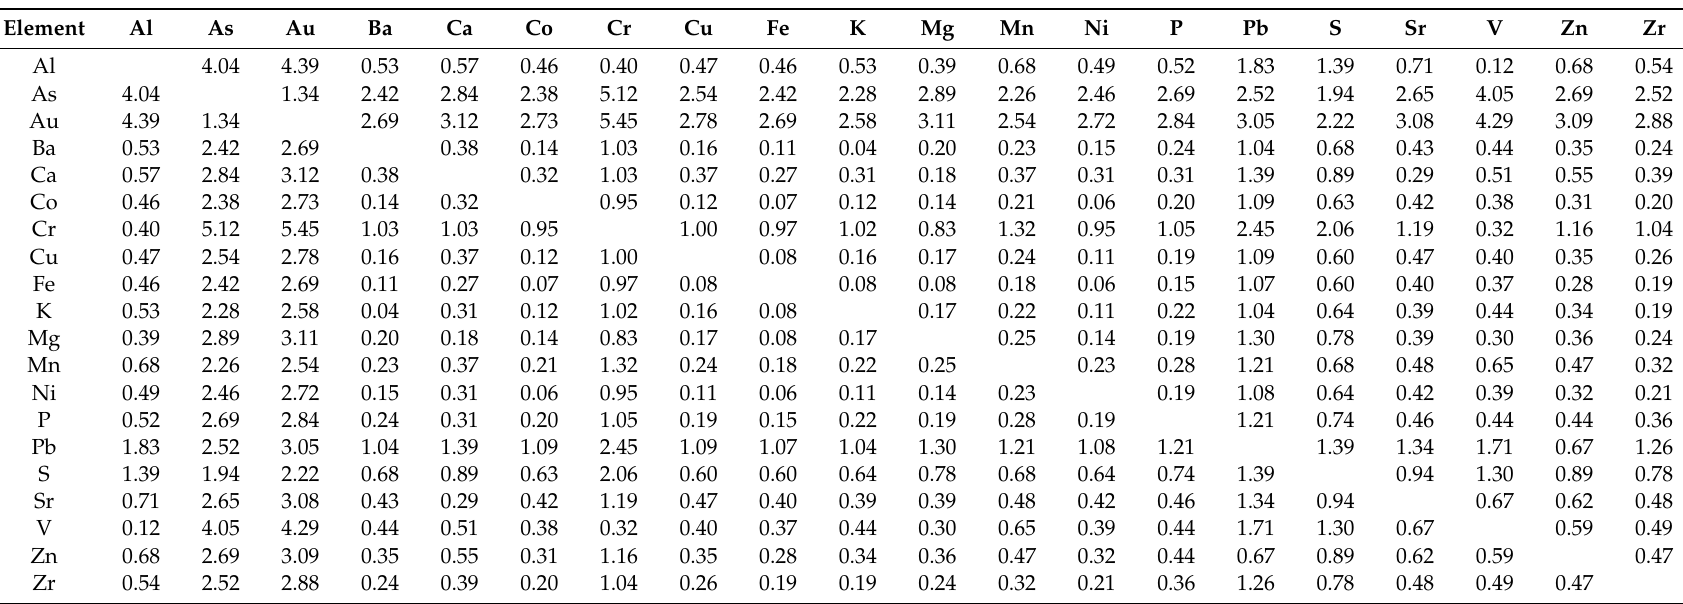
Table A2. Variation matrix for fresh rock observation data subset. Smallest number column-wise indicates strongest